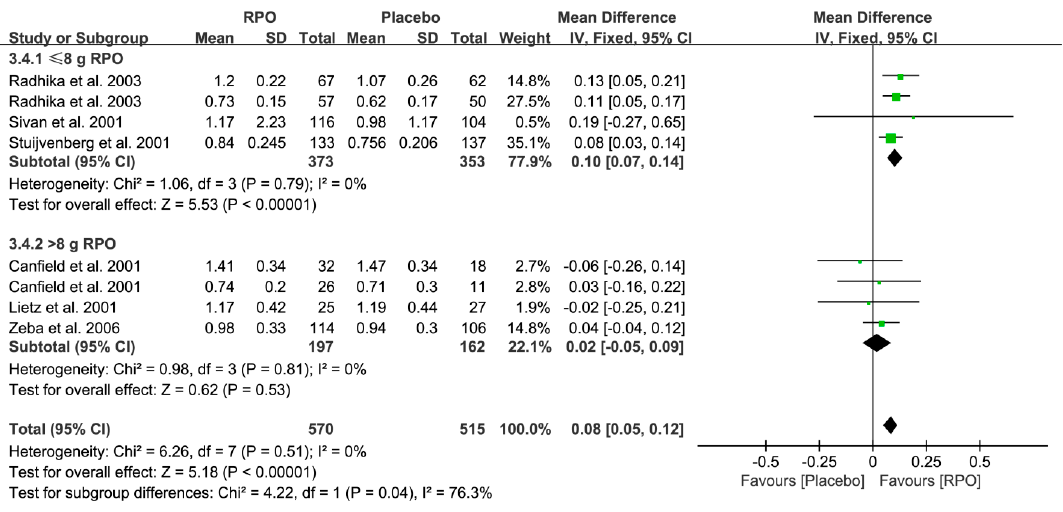
Figure 4. Subgroup analysis of serum retinol levels ( µ mol/L) following red palm oil (RPO) intervention with respect to low or high RPO intake (RPO group vs. placebo group). CI: confidence interval.